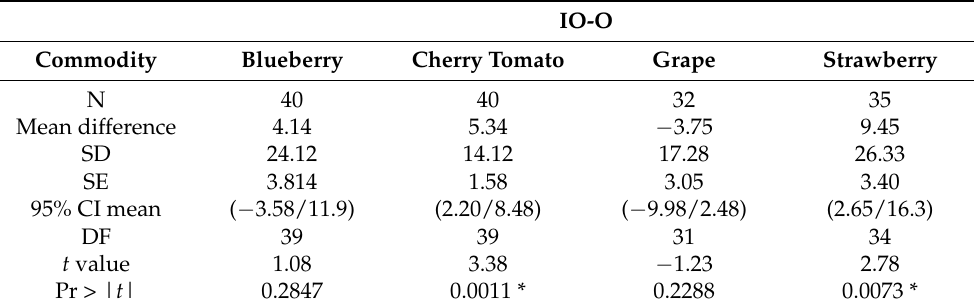
Figure 6. Boxplot represents the difference in the overall eating quality (IO-O). The dots represent outliers. Table 5. Paired t -test comparing overall eating quality (IO-O) between the images and real produce based on each